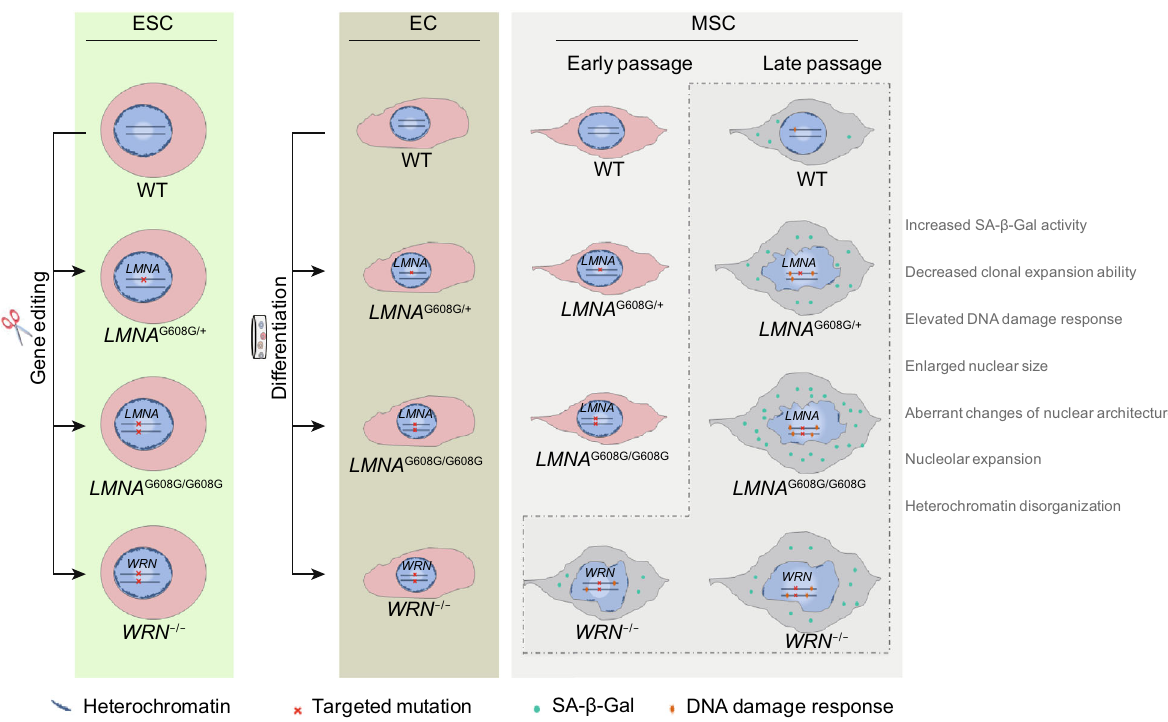
Figure 10. Schematic drawing of the major cellular phenotypes observed in HGPS- and WS-speci fi c ESCs, ECs and MSCs. HGPS-ESCs and WS-ESCs were generated by gene editing under the same genetic background, and further differentiated to ECs and MSCs. LMNA -mutant and WRN -de fi cient ESCs or ECs show no accelerated senescence related defects, while HGPS-MSCs and WS-MSCs exhibited aging-associated phenotypes with different kinetics, including self-renewal ability, DNA damage response, nucleolar expansion, as well as nuclear architecture and heterochromatin alterations. WS-MSCs had early-onset mild premature aging phenotypes while HGPS-MSCs exhibited late-onset acute premature aging